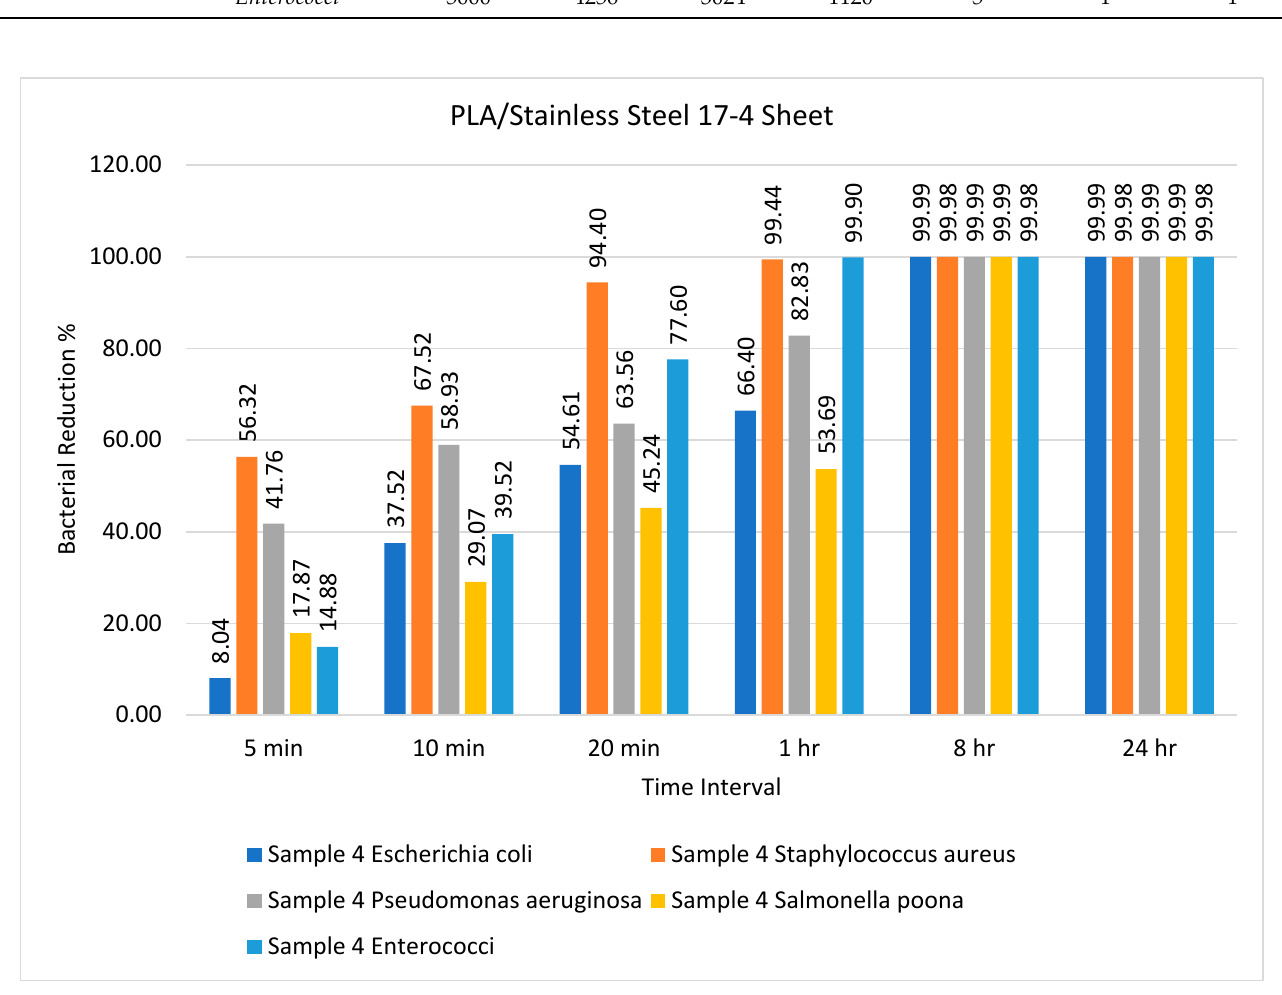
Figure 9. Percentage bacterial reduction for PLA/stainless steel 17-4 sheets over different time intervals.